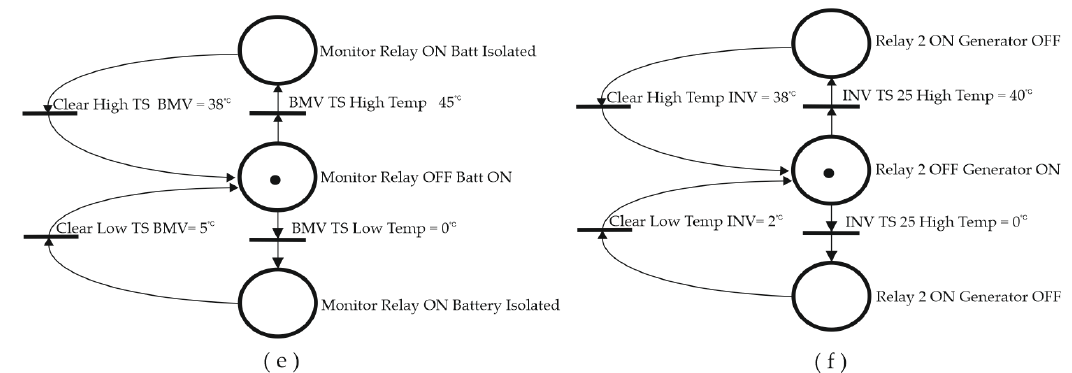
Figure 15. ( a ) Start/stop generator by Temperature Sensor 24 PN Model. ( b ) Start/stop generator by Voltage PN Model. ( c ) Start/stop generator by Current PN Model. ( d ) Start/stop generator by SOC PN Model. ( e ) Connection/disconnection of battery by BMV Temperature Sensor PN Model. ( f ) Start/stop generator by Temperature Sensor 25 PN Model.